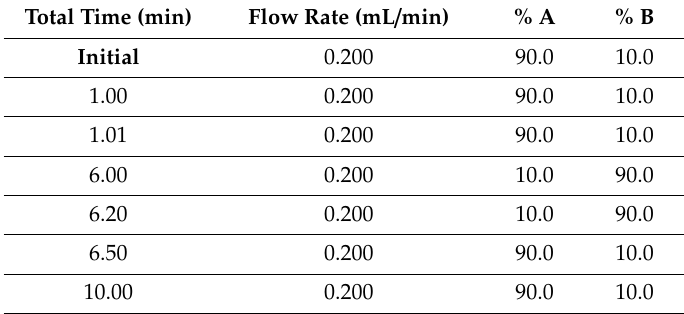
Table 2. The mass parameters were fine-tuned for maximum sensitivity, and parent ion transitions were selected to a ff ord the best response for the spectrum analysis. The method was validated using these optimized conditions. Table 1. Gradient conditions used for the LC–MS / MS analysis. Total Time (min)